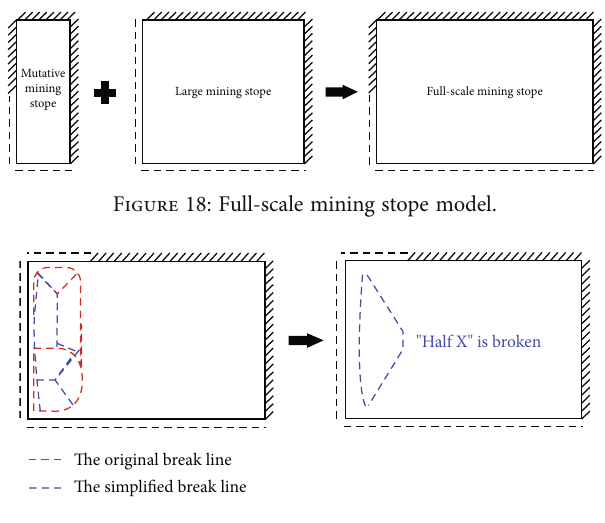
Figure 19: “ Half X-shaped ” fracture in full-scale mining stope.